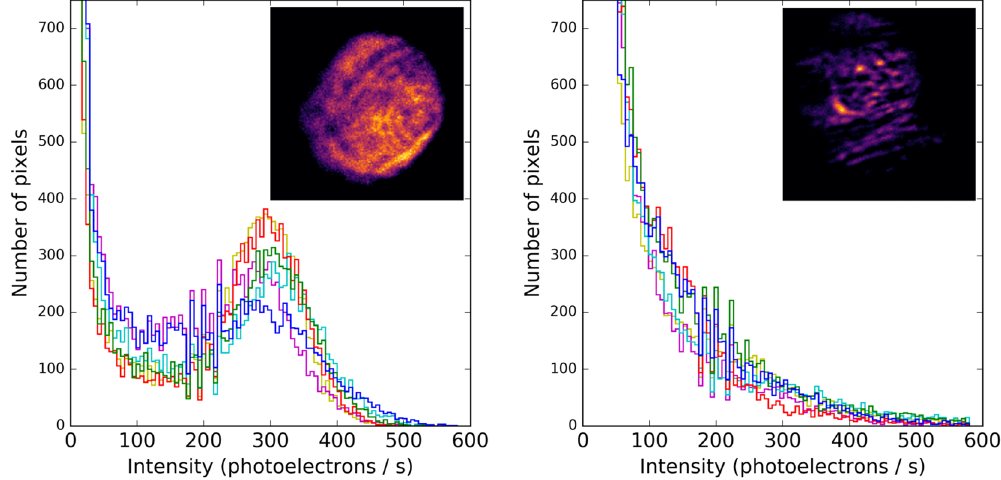
Figure 7. Example of barium-chelated (left) and unchelated (right) fluorescence microscope images. The histograms show the pixel intensity populations, with a clear excess visible in the “on” slide. The multiple colored histograms are various locations within the fluorescent spot, chosen at random. The insets show two example microscope images at specific